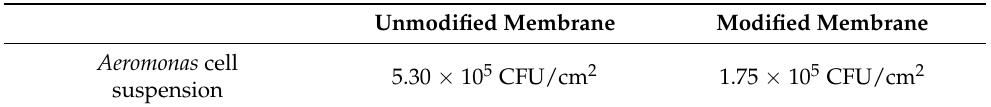
Table 3. Adhesion of Aeromonas hydrophila onto the membrane surface of the modified and unmodified